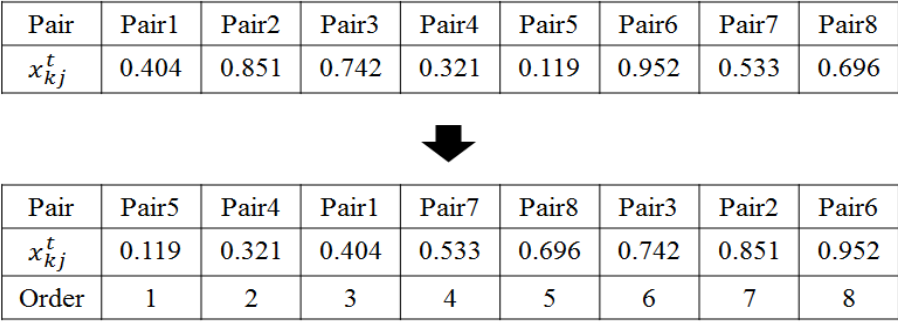
Figure 2. Sequence of the PSO continuous code.